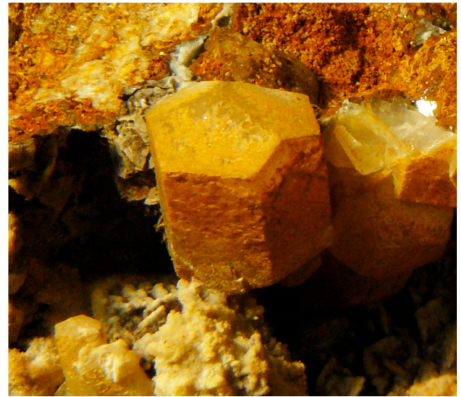
Figure 4. Calcite and iron-rich dolomite from the Dodge mine. The calcite crystal is 1 cm high. Chamberlain Collection, NYSM 11380. SC.